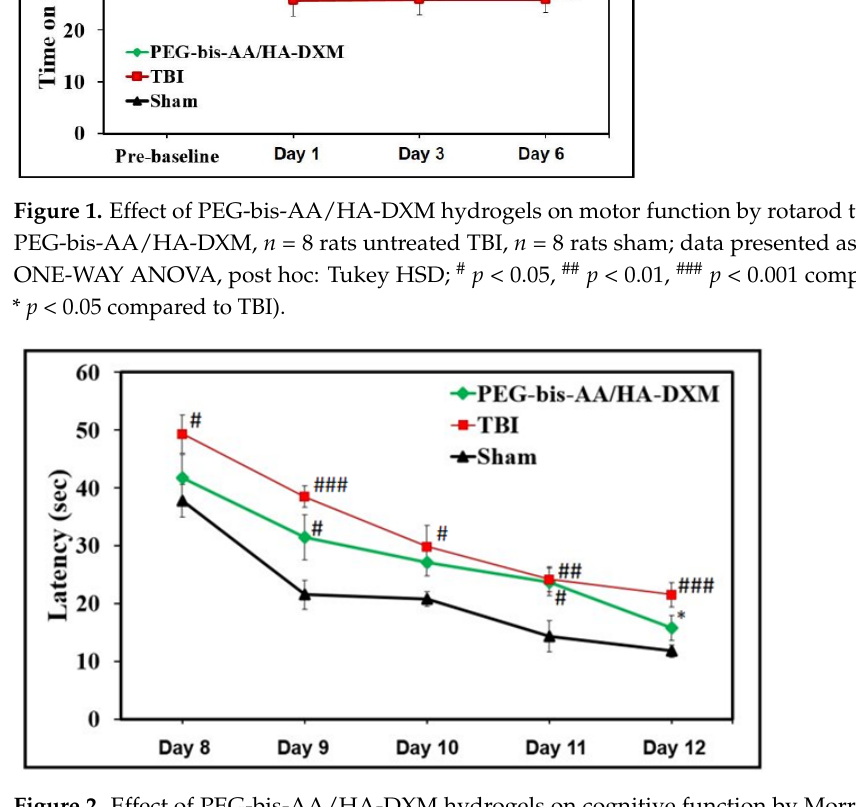
Figure 1. Effect of PEG-bis-AA/HA-DXM hydrogels on motor function by rotarod test. ( n = 9 rats PEG-bis-AA/HA-DXM, n = 8 rats untreated TBI, n = 8 rats sham; data presented as mean ± STD; ONE - WAY ANOVA, post hoc: Tukey HSD; # p < 0.05, ## p < 0.01, ### p < 0.001 compared to sham; * p < 0.05 compared to TBI).